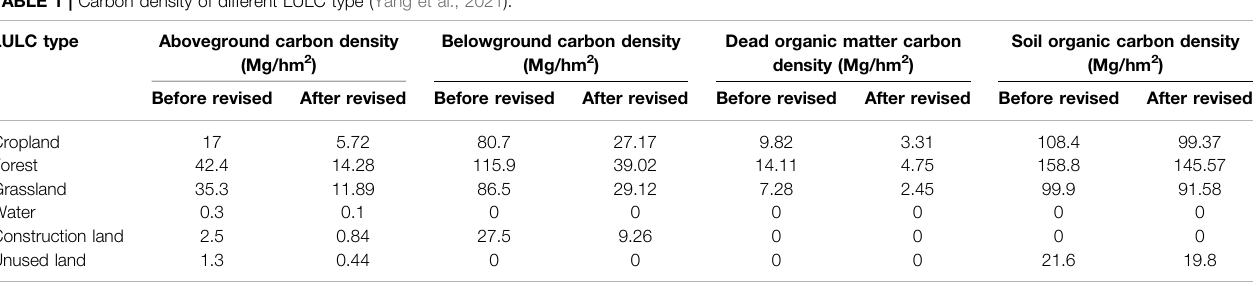
TABLE 1 | Carbon density of different LULC type (Yang et al.,